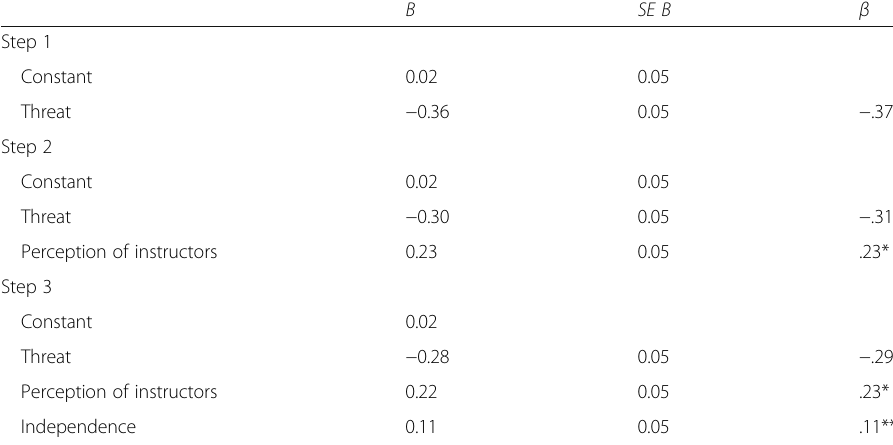
Table 5 Students ’ attitudes that predict whether seek help from instructors B SE